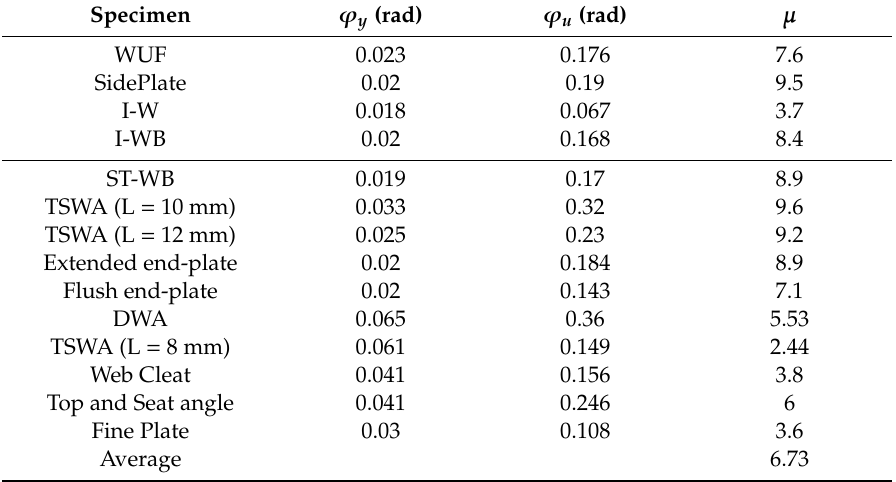
Table 5. Yielding Rotation, Maximum Rotation Capacity, and Ductility of Studied Specimens.